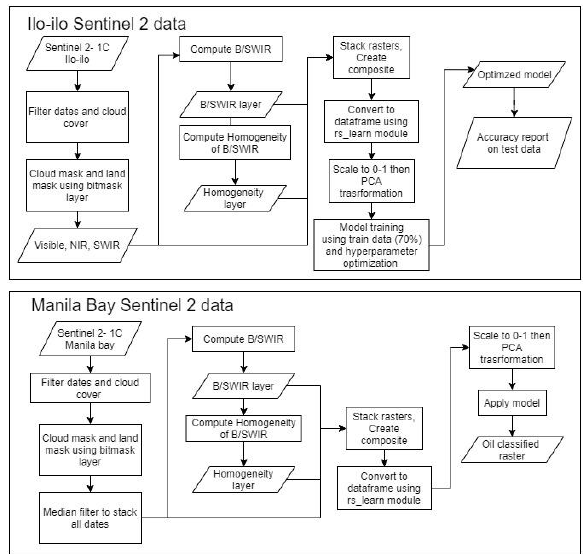
Figure 5. The overall workflow for mapping oil spill 4.